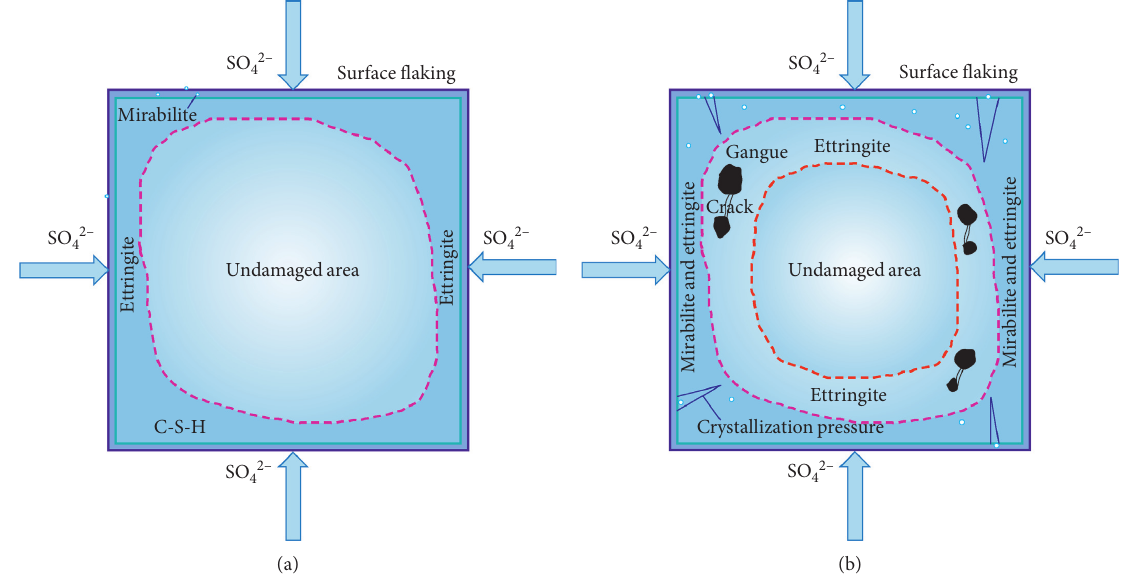
Figure 11: Damage process of CGFB samples under sulfate attack of drying-wetting cycles at the (a) first stage and (b) second